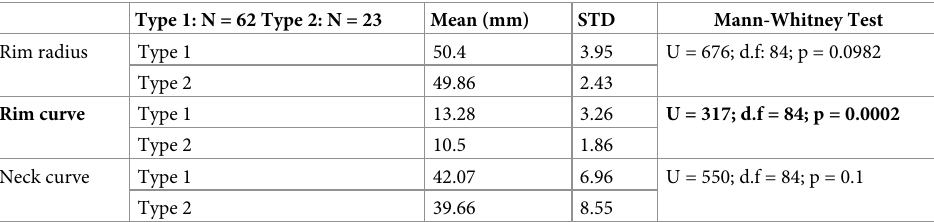
Table 4. Significance test results for the rim radius, rim- and neck-curve lengths among the two main